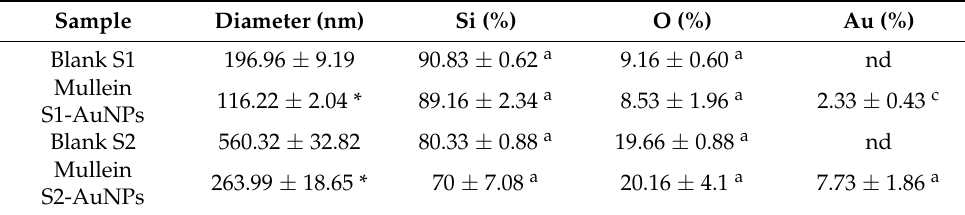
Table 1. The diameter size and EDS composition of silica-gold nanoparticles.